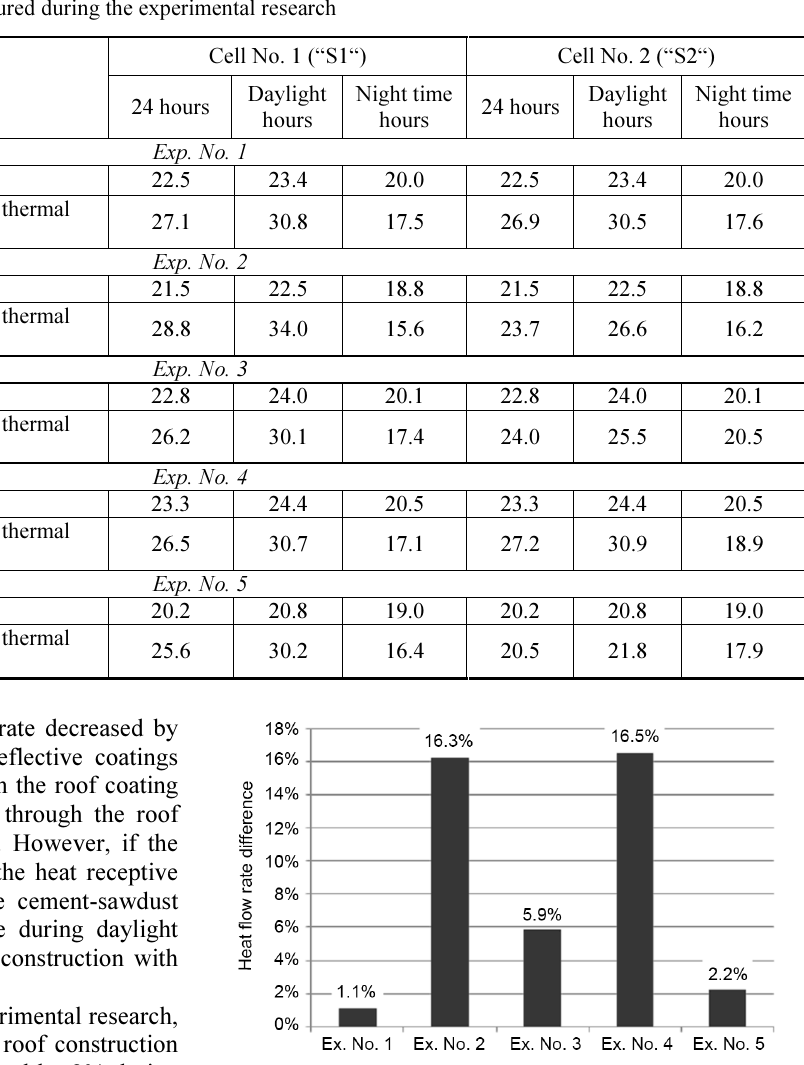
Fig. 6. Average heat flow rate differences through the cell roof constructions during night time